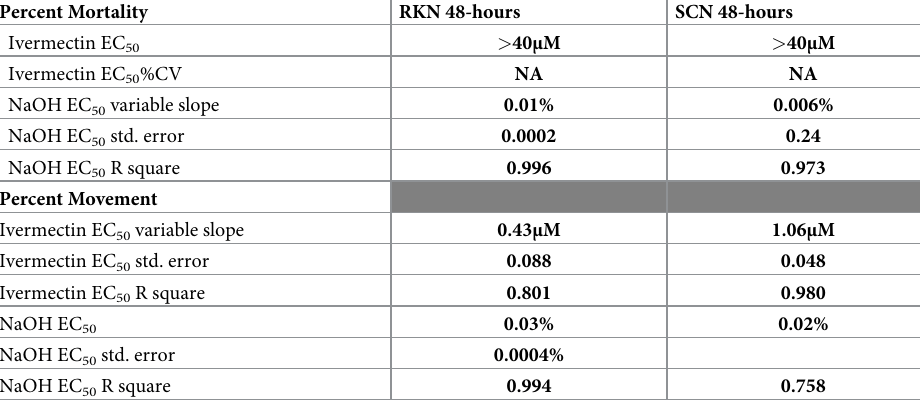
Table 3. Calculated EC 50 values for ivermectin and